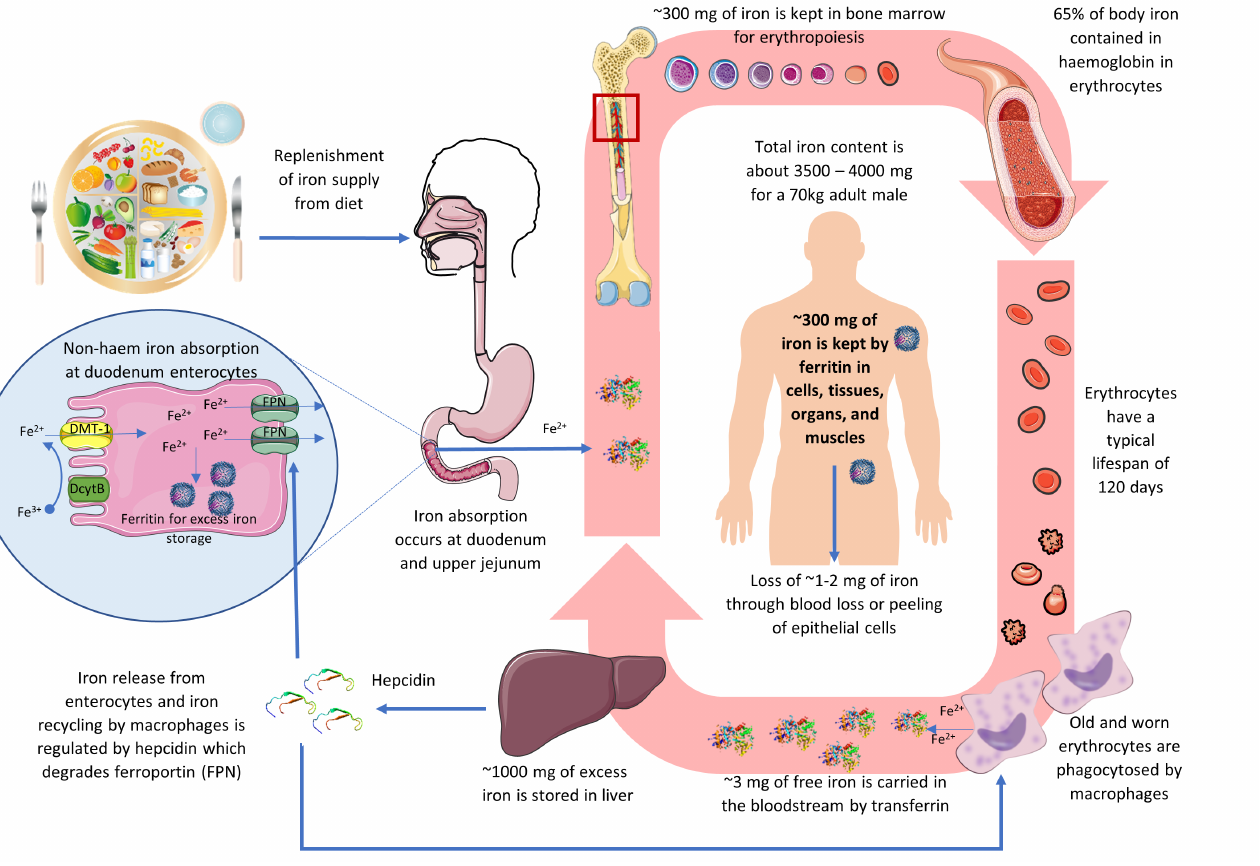
Figure 2. An overview of the iron cycle in humans depicting iron absorption, transportation, func- tioning, recycling, storage, and